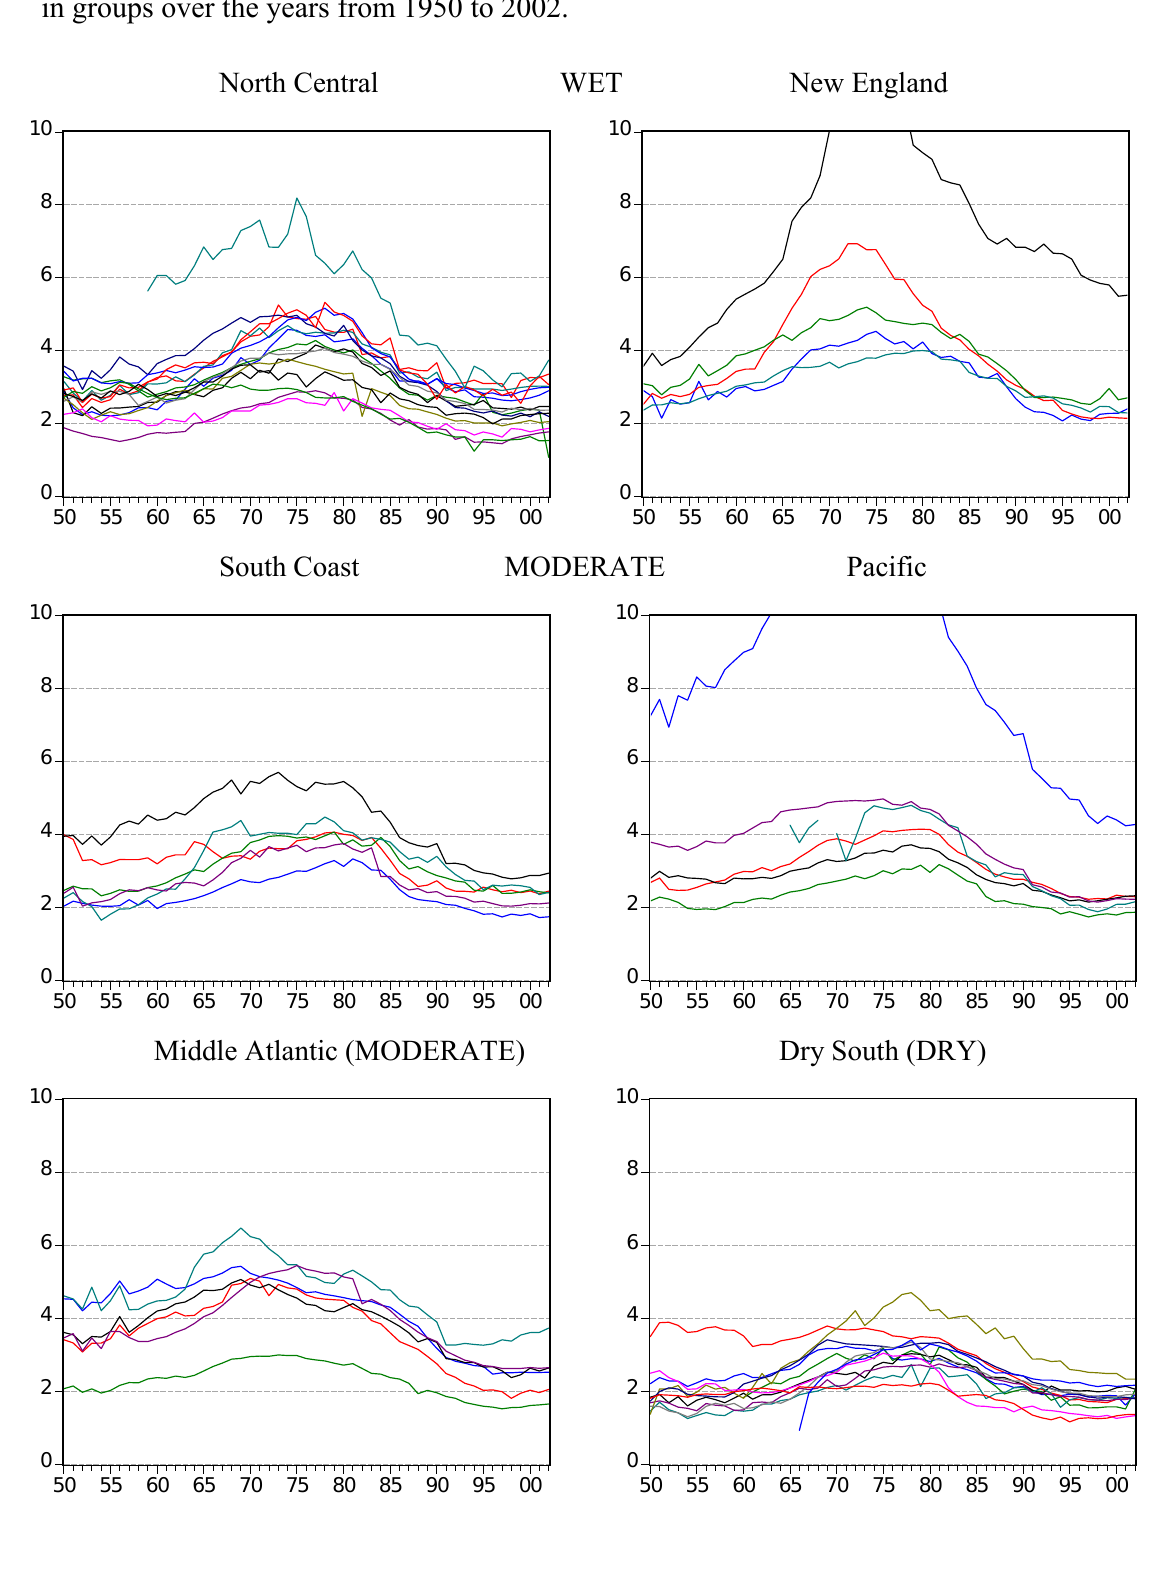
Figure 3. Apparent consumption of spirits in liters of ethanol per capita aged 15+ by state in groups over the years from 1950 to 2002. North Central